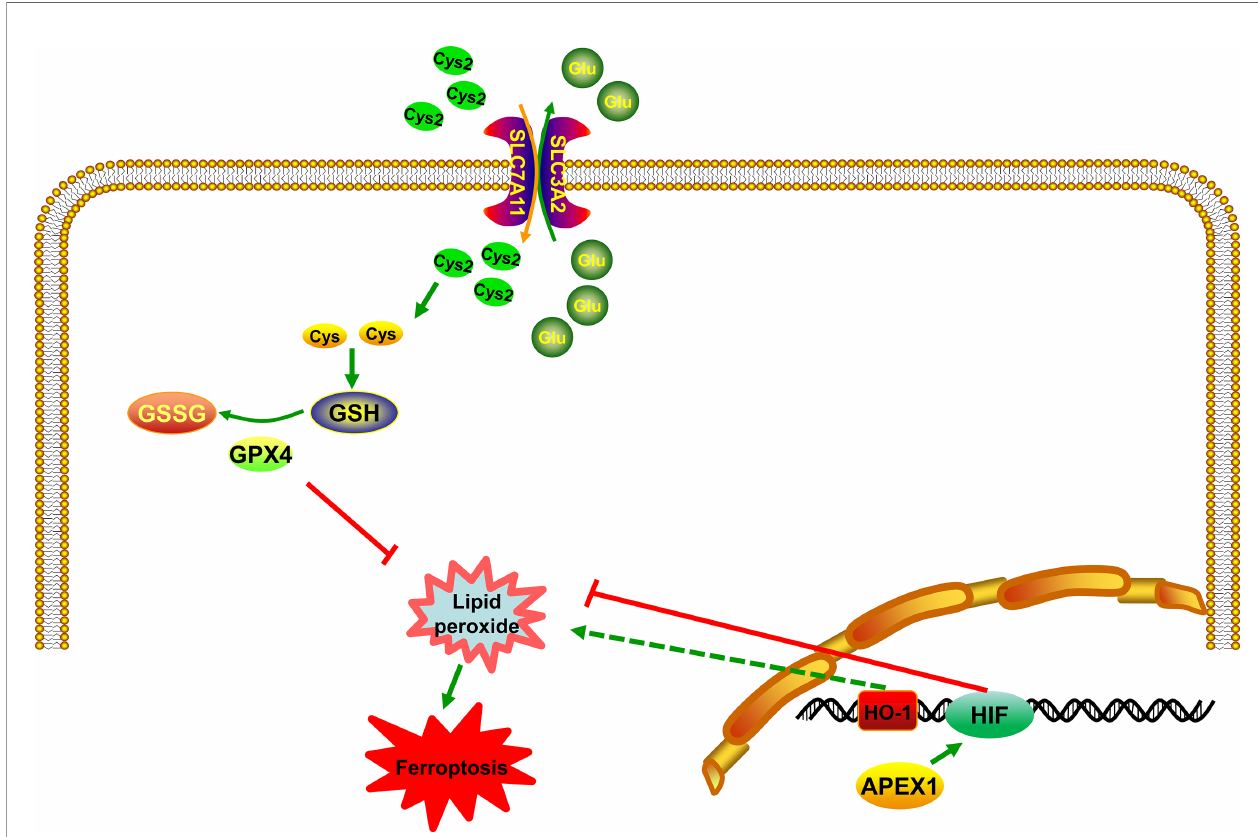
FIGURE 3 | APEX1 inhibits ferroptosis by regulating the HIF pathway. APEX1 regulates regulate ferroptosis by interacting with HIF. HO-1 has a dual role in